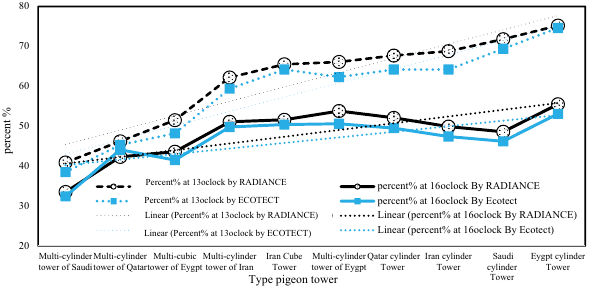
Figure 6. The percentage of the received sunlight by the surfaces of the pigeon towers in Central Asia and analyzed in Radiance and that of shadow analyzed in